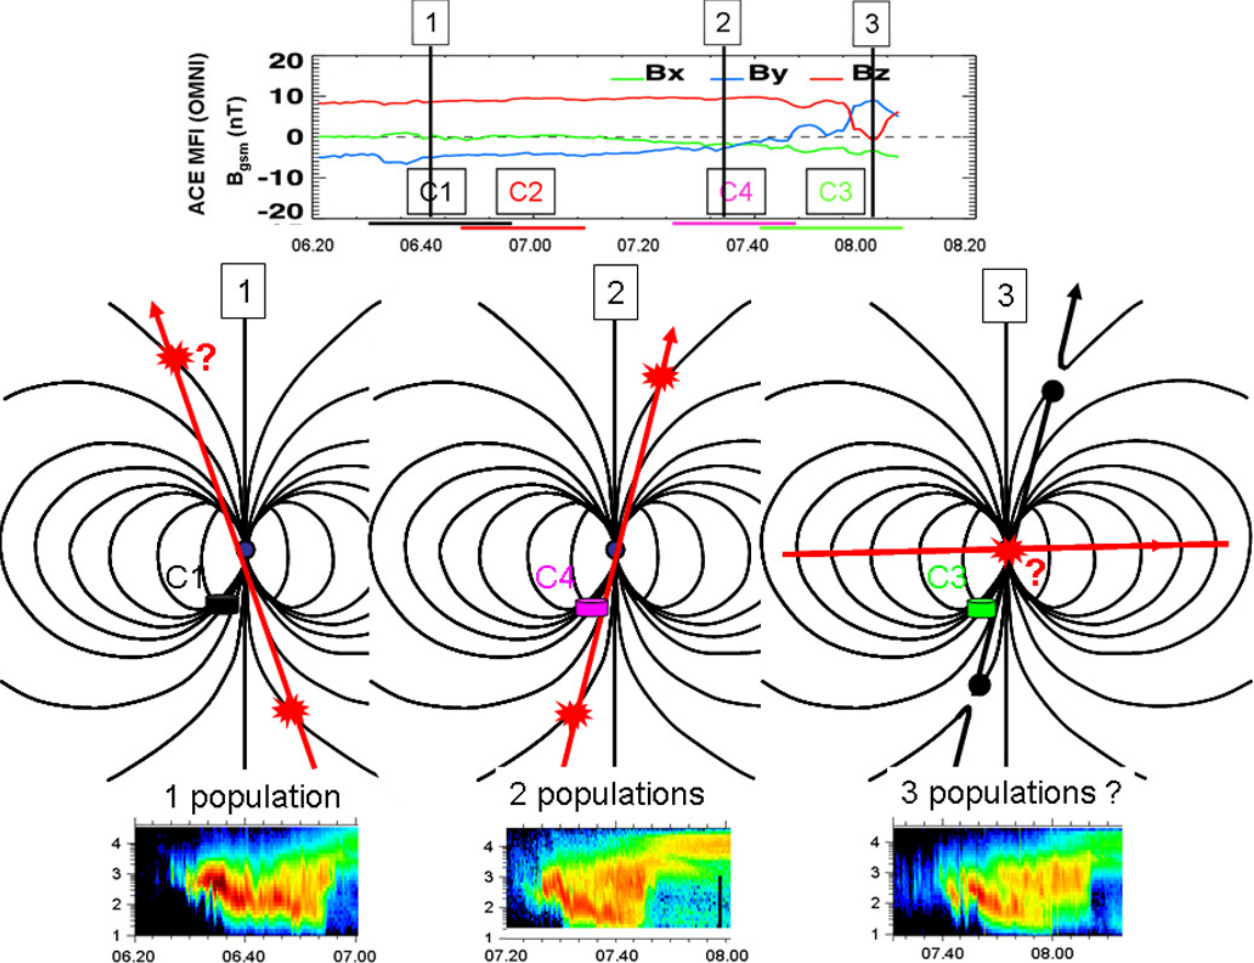
Fig. 13. The top panel shows the lagged magnetic field data recorded by ACE (labels indicate the three successive stages discussed). Below is a schematic for each of the three steps showing the magnetosphere seen from the sun with possible reconnection sites in red. Black lines are magnetospheric field lines and red lines represent IMF lines. At the bottom are the corresponding Cluster-CIS